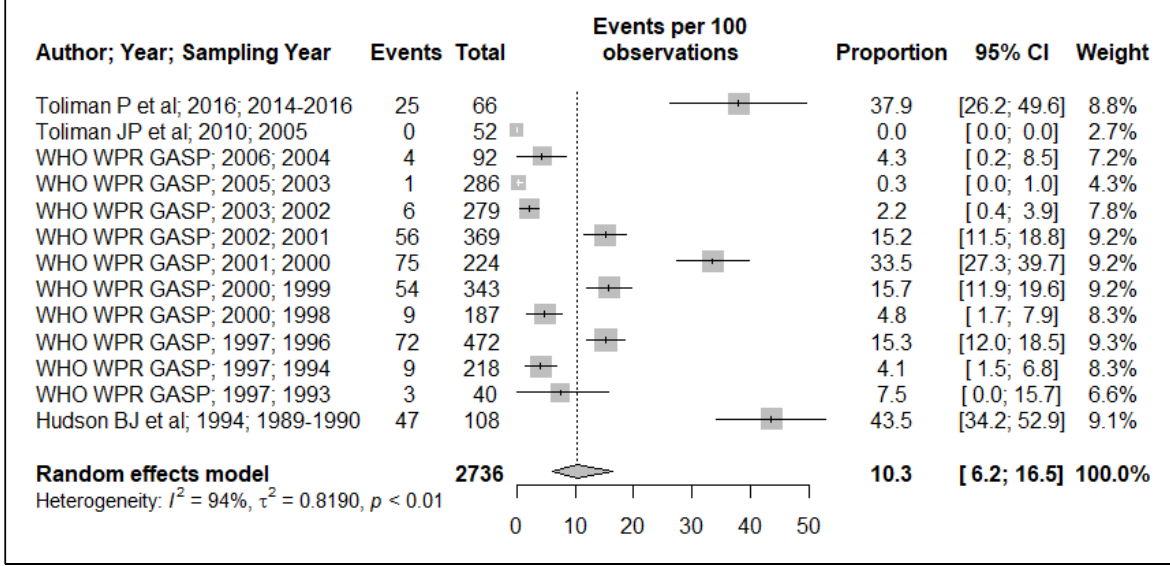
Int. J. Environ. Res. Public Health 2022 , 19 , x FOR PEER REVIEW Figure 4. Tetracycline resistance prevalence estimate. Figure 4. Tetracycline resistance prevalence estimate.